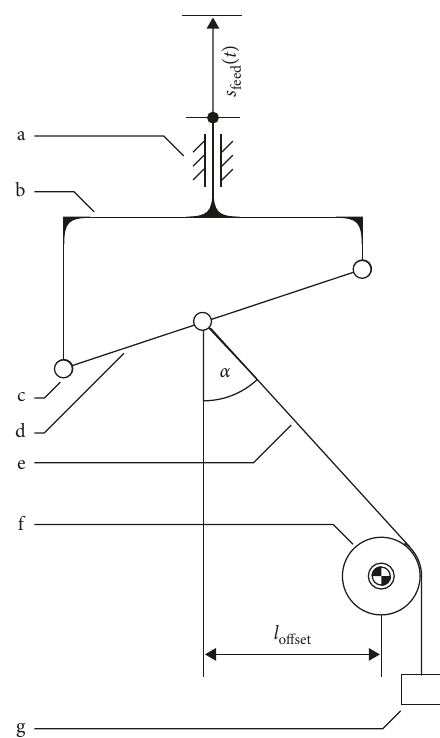
Figure 4: Schematic sketch of the test of the force sensors. (a) Uniaxial guidance. (b) Framework for tensioning the wire. (c) Thick wire. (d) Clamping wire. (e) Thinner wire. (f) Pulley. (g) Test mass. Angle of the acting force in relation to the feed di- rection α . Feed as a function of time s feed ( t ). Distance between pulley pivot point and feed axis l offset . Test mass m attached to a wire.